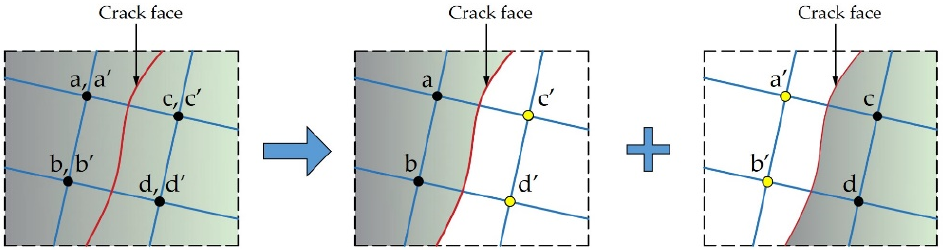
Figure 1. Virtual node and formation of new elements as crack propagates.